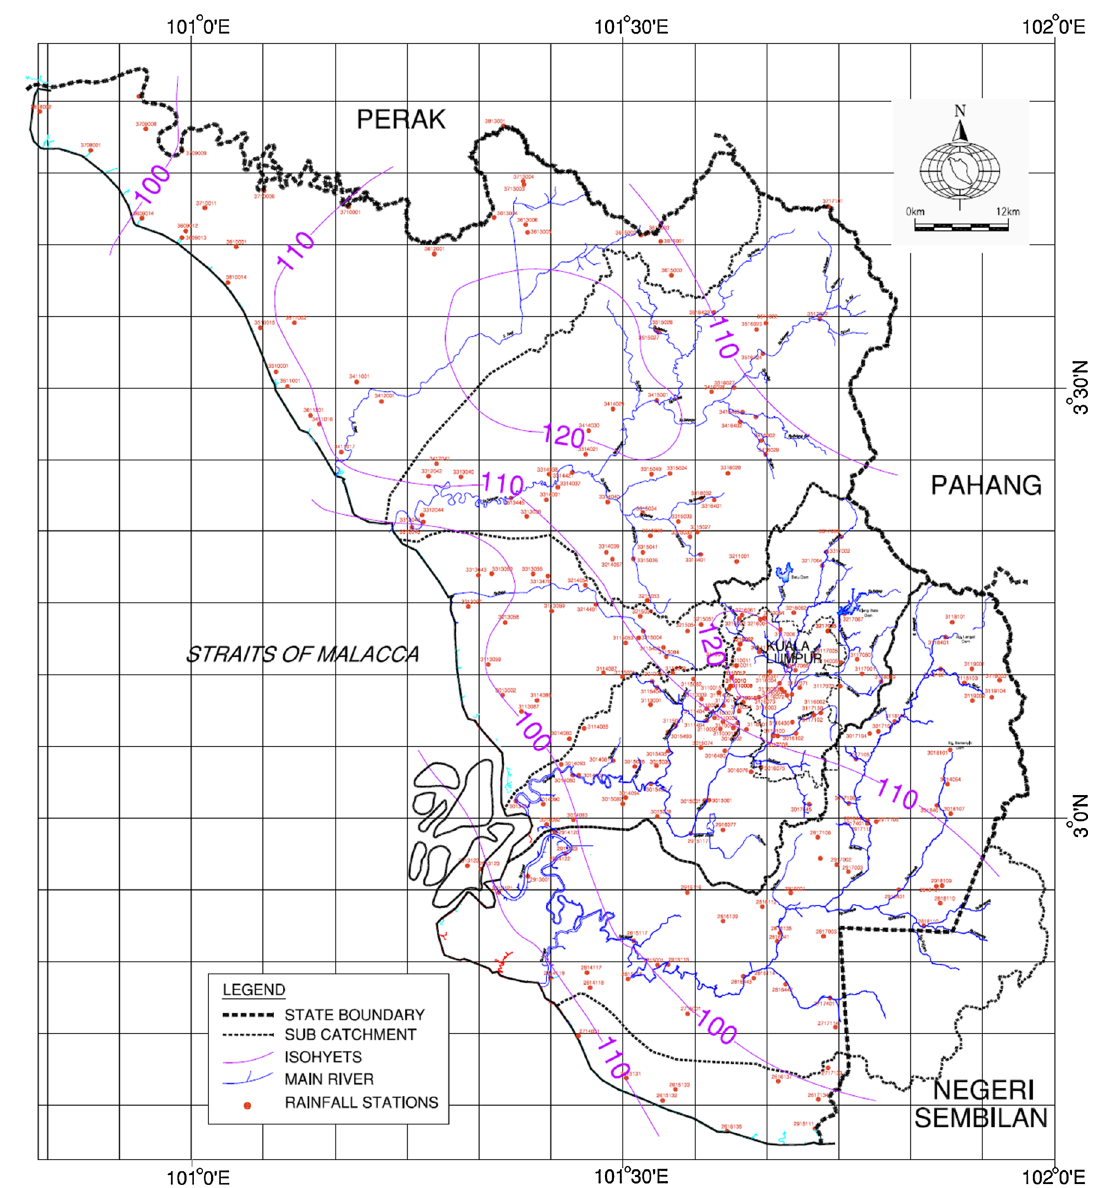
Fig. 2 Isohyets of mean annual daily (24 h) maximum rainfall in Klang